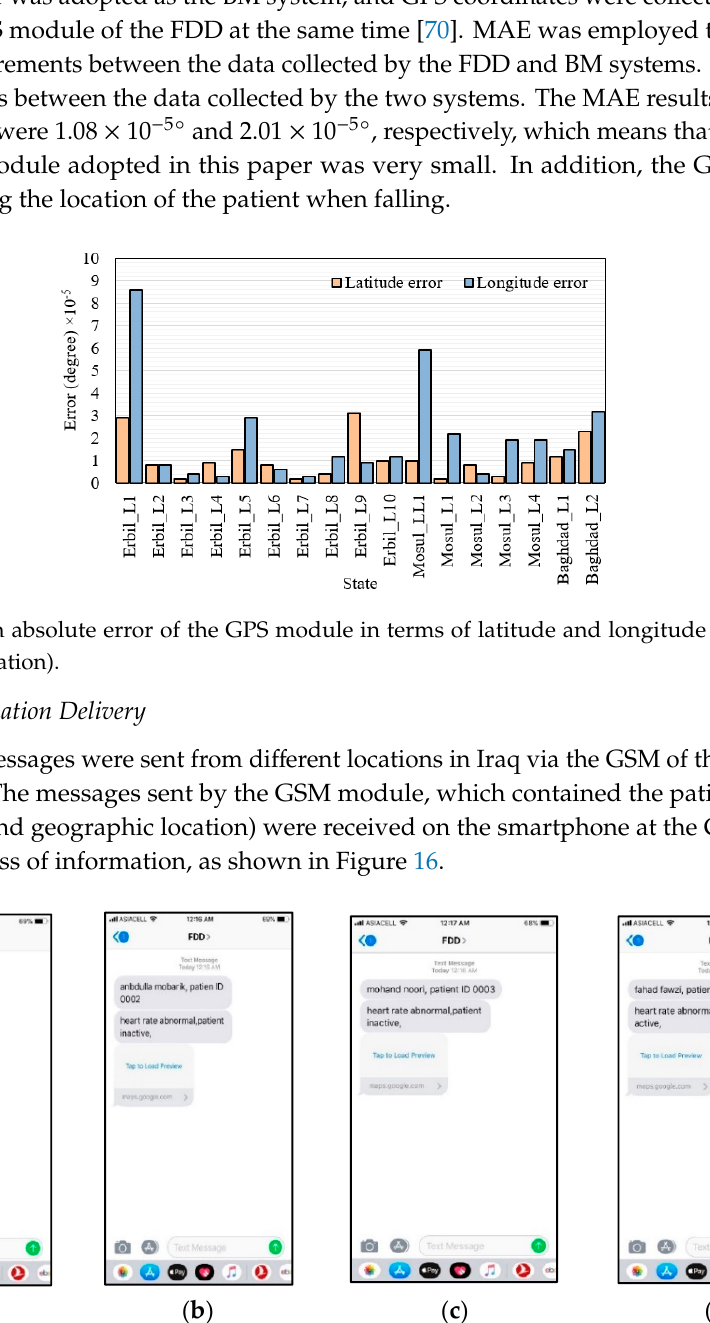
Figure 14. Measurements of the FDB ‐ HRT algorithm for three volunteers: ( a ) 28, ( b ) 30, and ( c ) 31 years old.